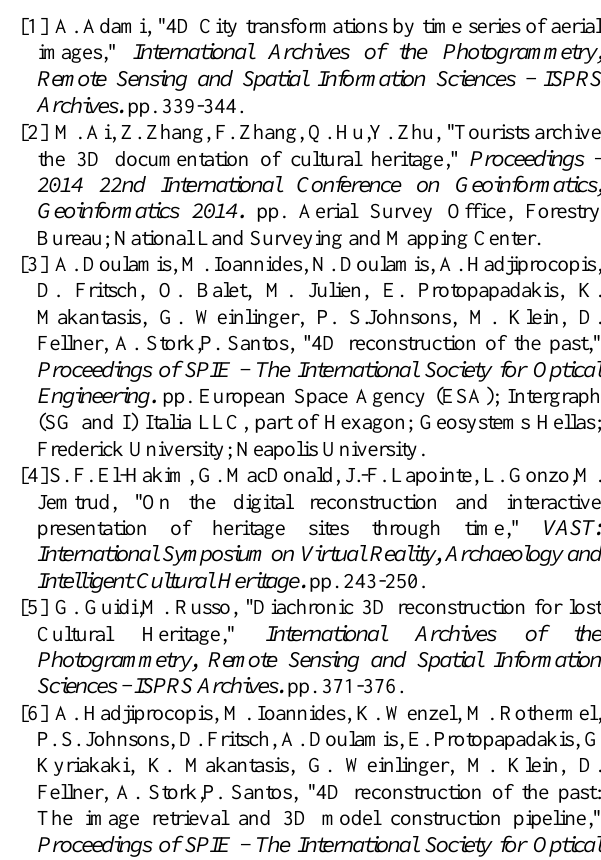
Figure 3 . The texture images of 3D model is changing as the time